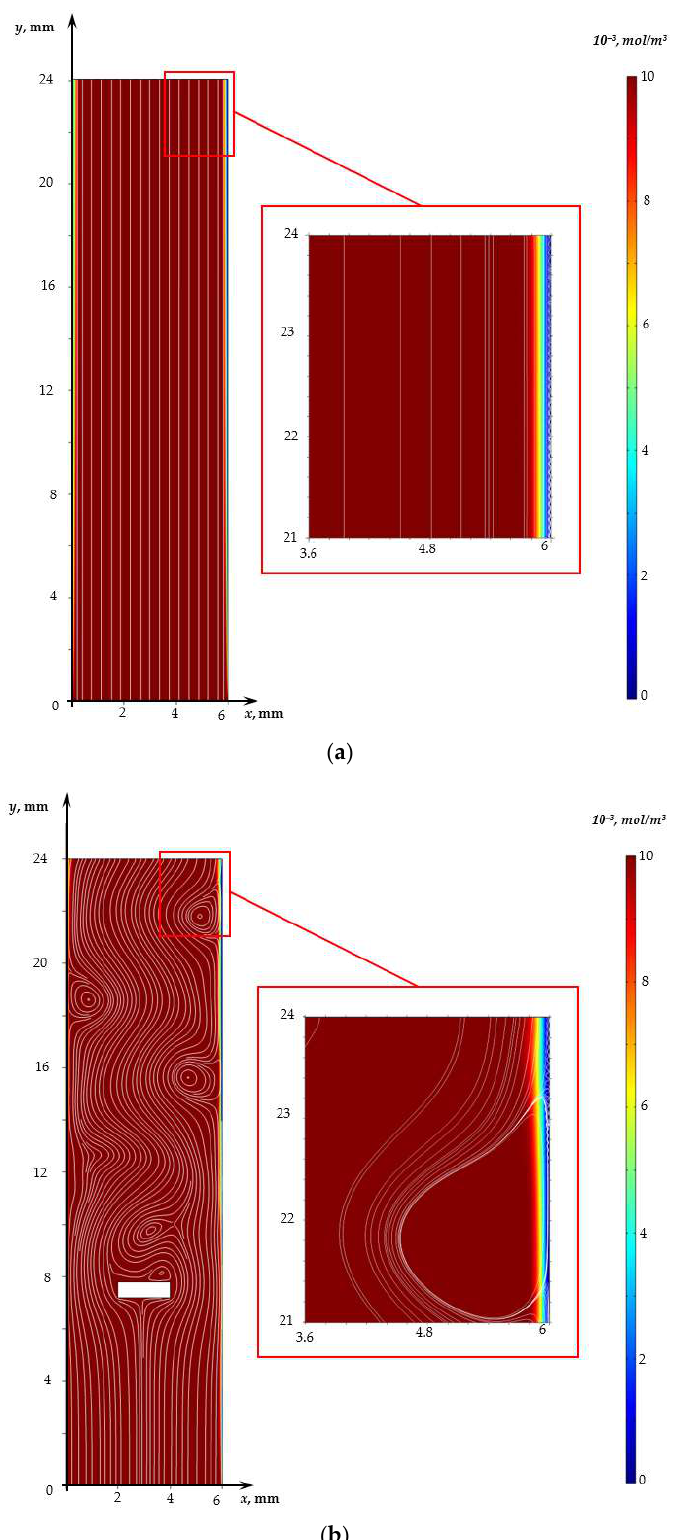
Figure 2. CVCs calculated for the desalination channels of an electrodialysis apparatus with NaCl solution without a spacer (blue line) and with a spacer insert in the center of the channel (red line).